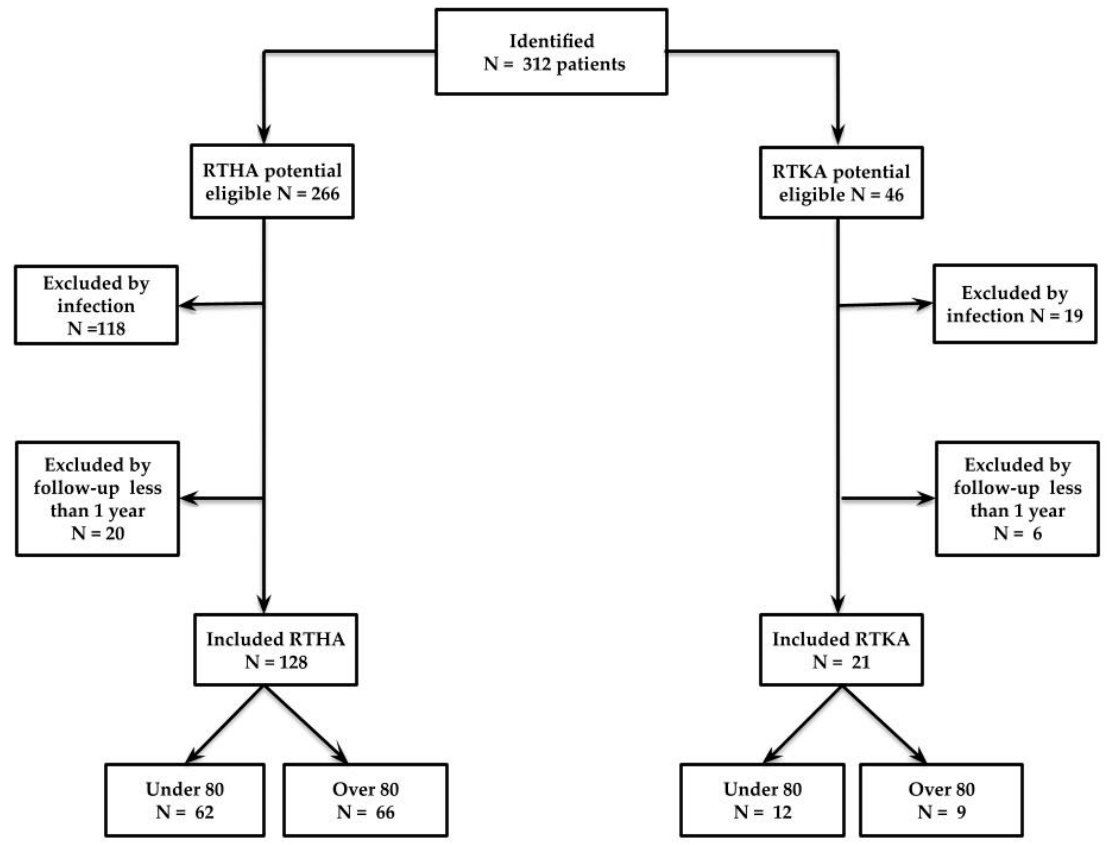
Figure 1. Flow chart of the patient selection and inclusion process. RTHA, revision total hip arthroplasty; RTKA, revision total knee arthroplasty.